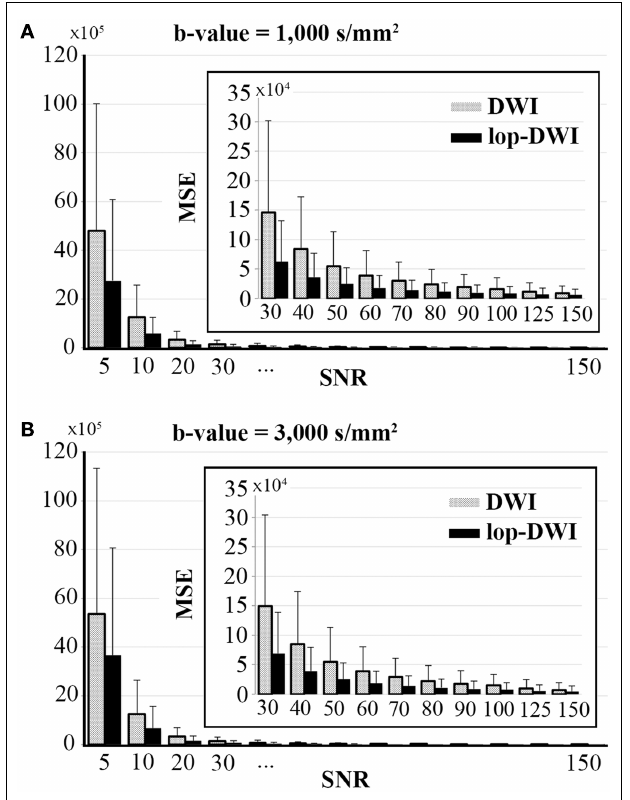
FIGURE 3 | Mean square error over different SNRs for digital phantoms, simulated with (A) b -value = 1,000s/mm 2 , and (B) b -value = 3,000s/mm 2 .To aid visualization of MSE values, bar charts for SNRs above 30 were expanded and shown inside each